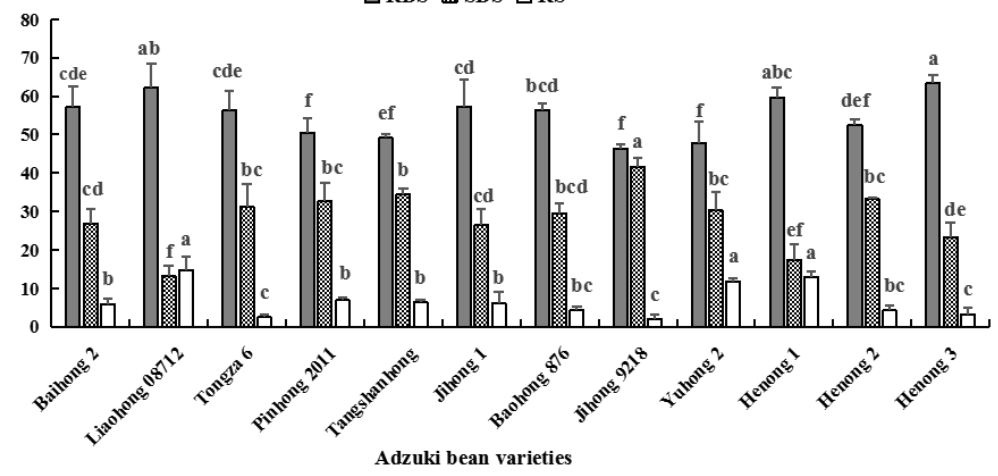
Figure 4. Contents of RDS, SDS and RS in starch. Note: Different lowercase letters indicate significant difference of 0.05 level, LSD method.